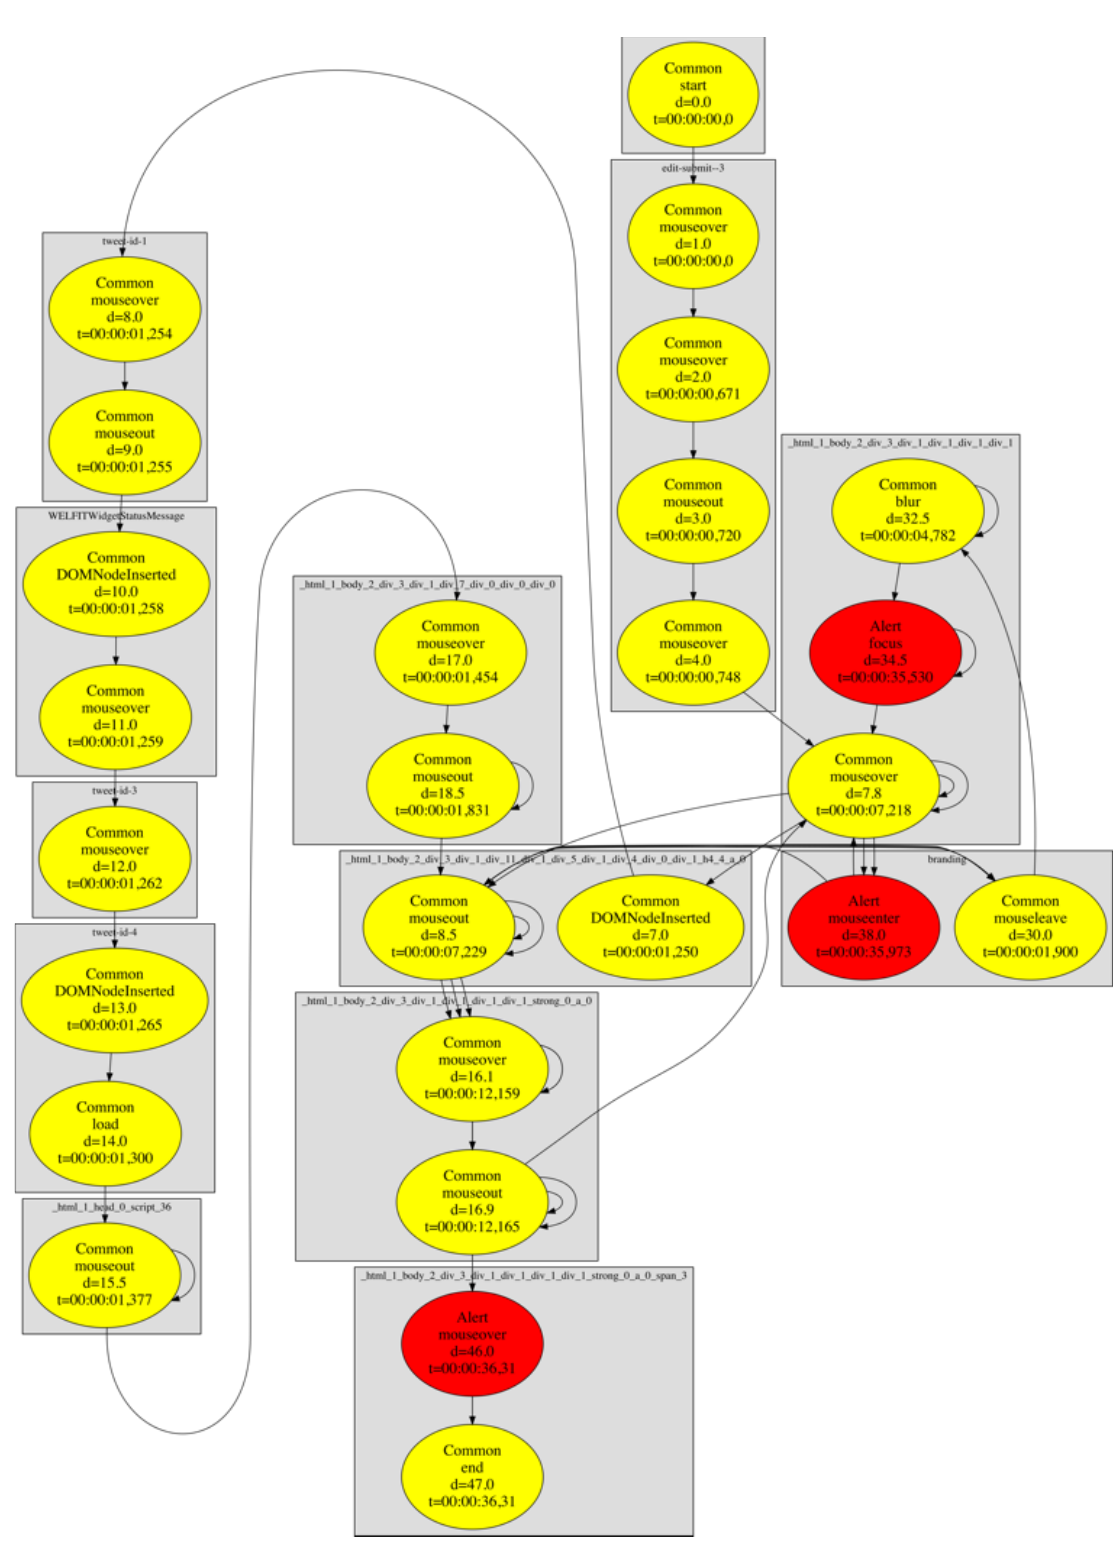
Fig. 1. Example of the usage graph of one of the analyzed sessions; highlighted nodes are the usability problems candidates pointed out by the